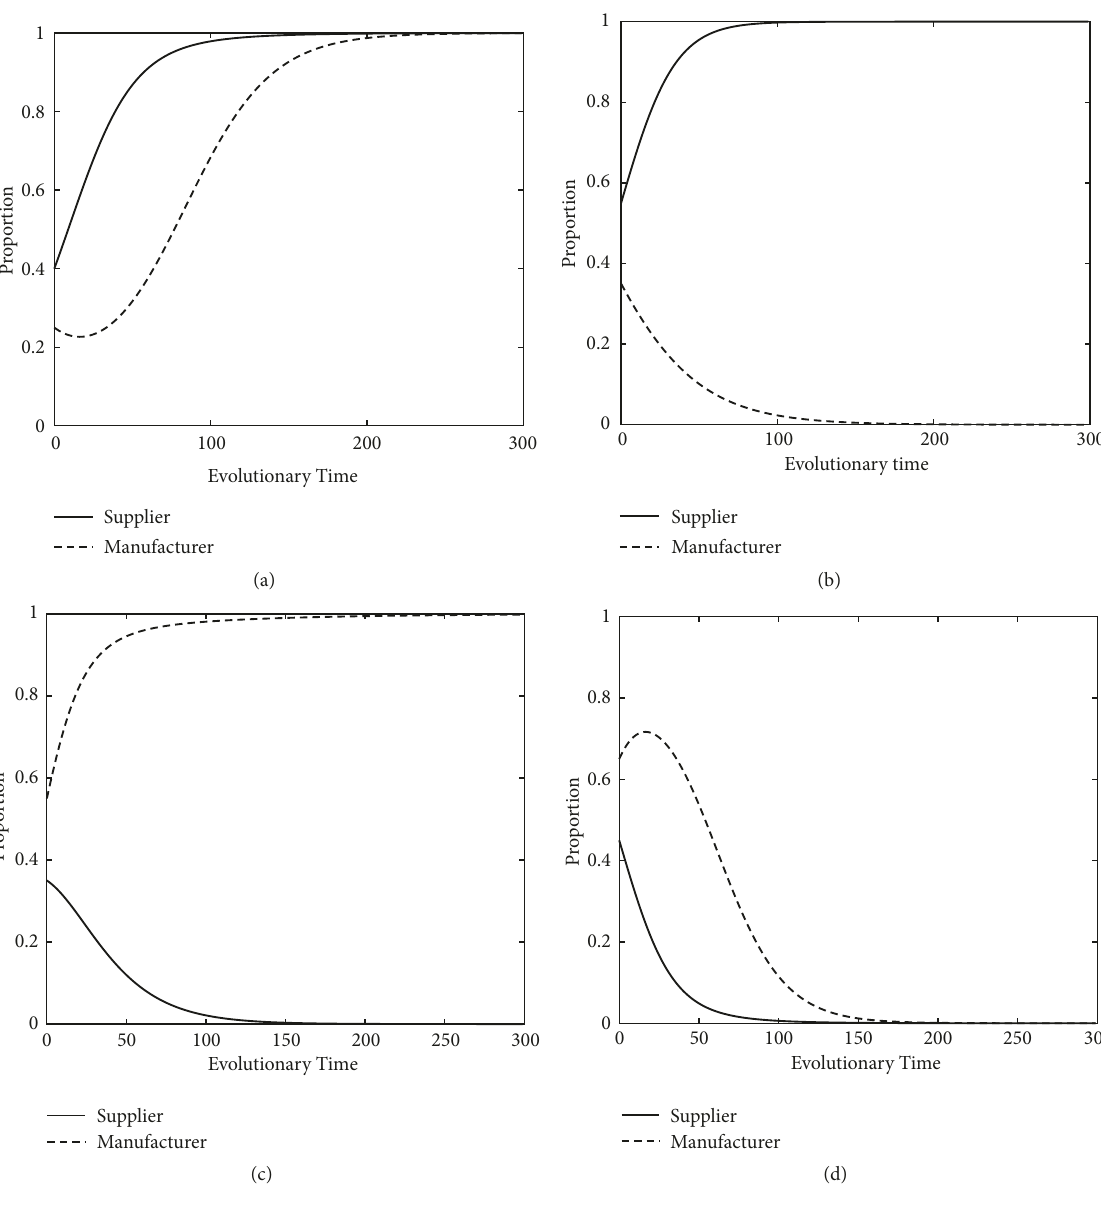
Figure 3: The evolutionary processes